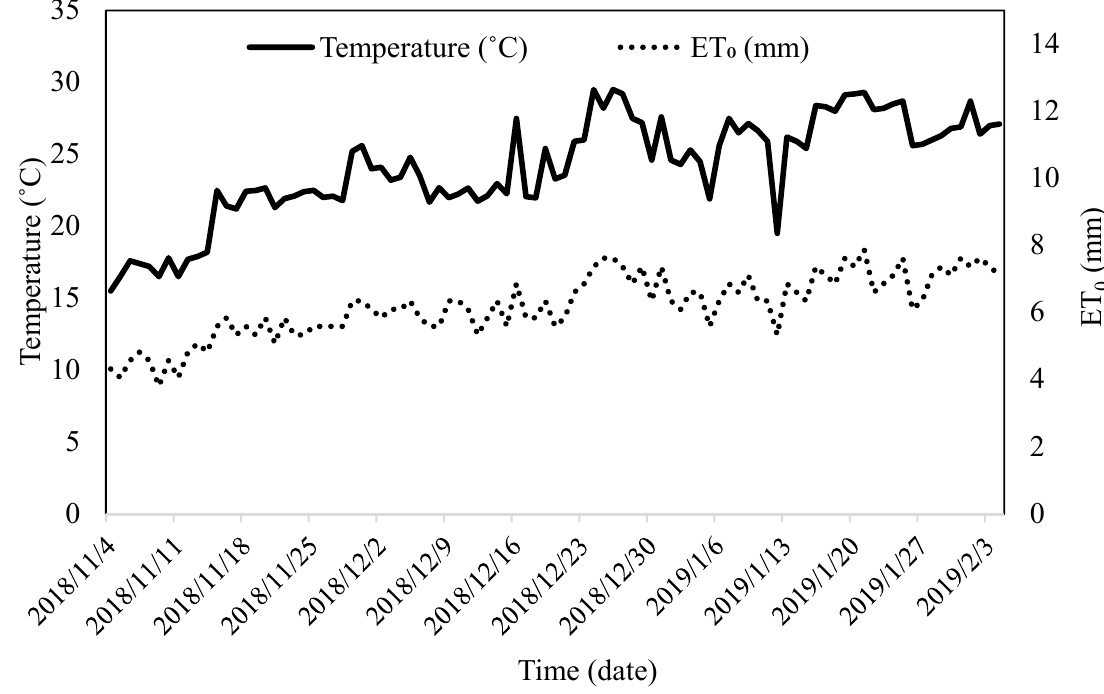
Figure 2. Measured daily air temperature (°C) and ET 0 values in the greenhouse. (ET 0 is reference crop evapotranspiration).